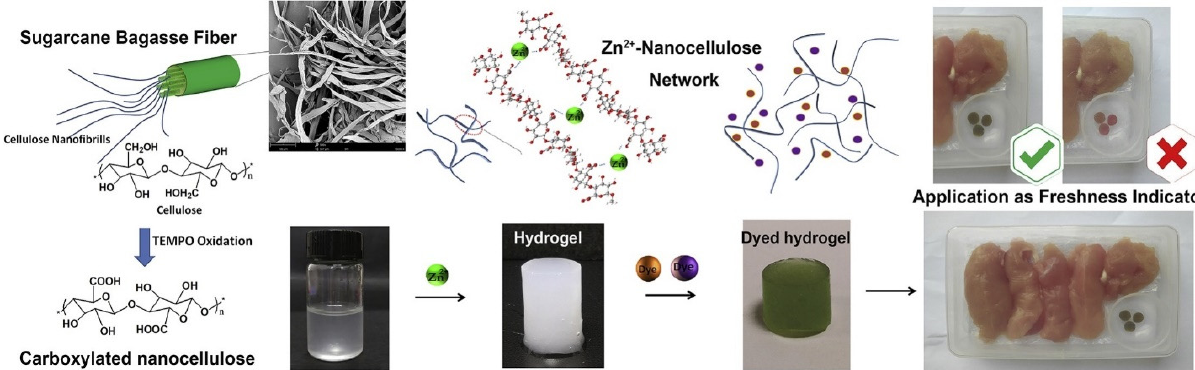
Figure 13. Design of CNF-based smart freshness indicator prepared by a 2,2,6,6-tetramethyl piperidinyl-1-oxyl (TEMPO) catalysis method for monitoring degradation in packaged meat, used with permission from ref. [44].